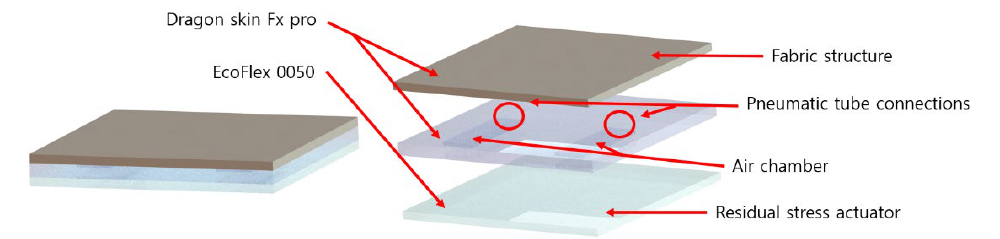
Figure 8. Decomposition of soft drive mechanisms.